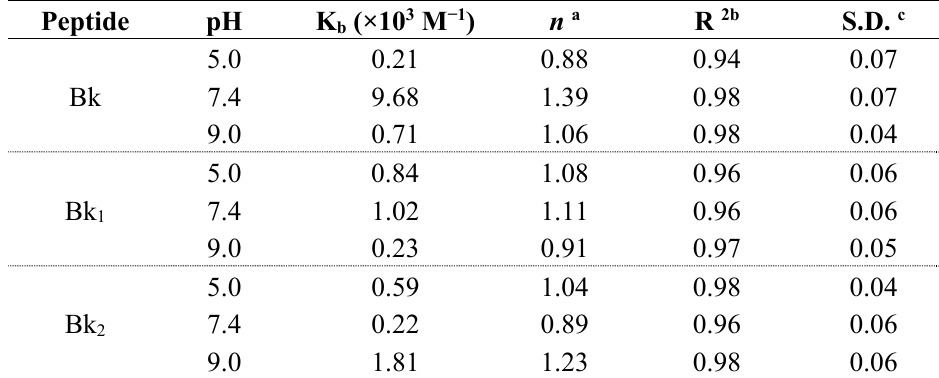
Table 3. Binding constants K b and binding sites ( n ) of BTCI in complex with Bk, Bk 1 and Bk 2 at different pHs.